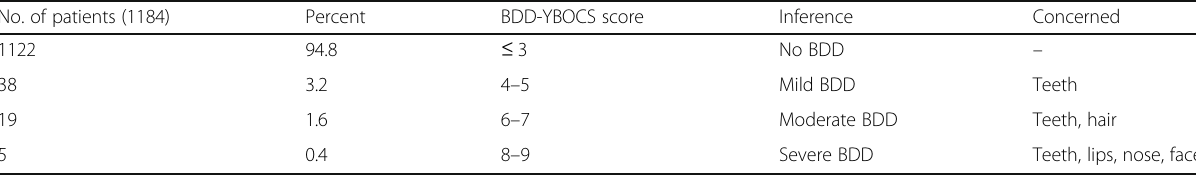
Table 1 Results of the BDD-YBOCS questionnaire No. of patients